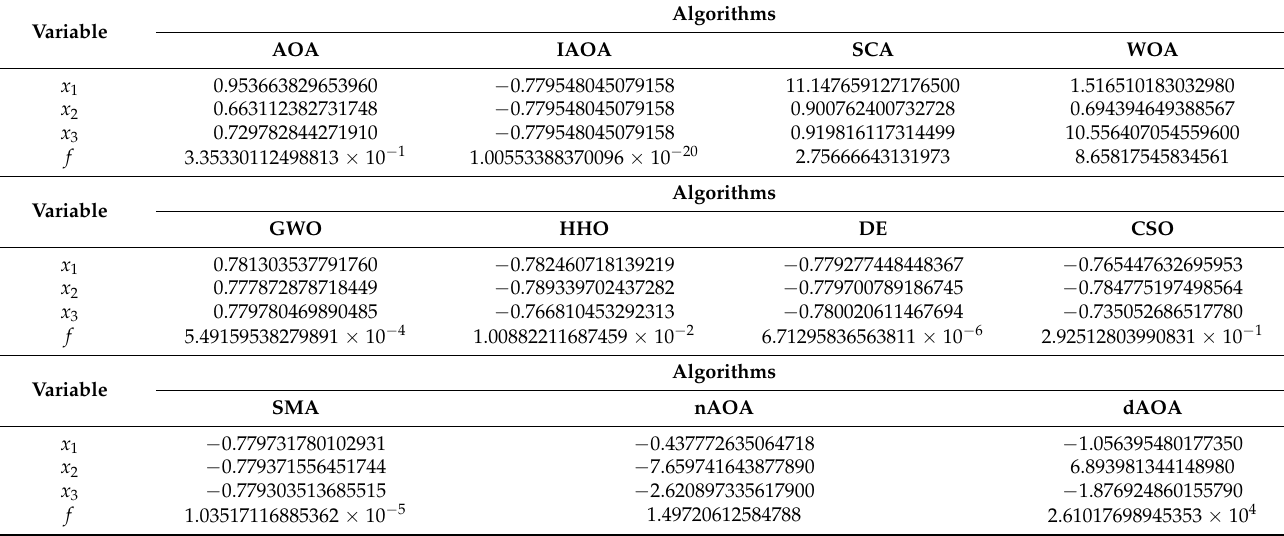
Table 6. Comparison of the experimental results for